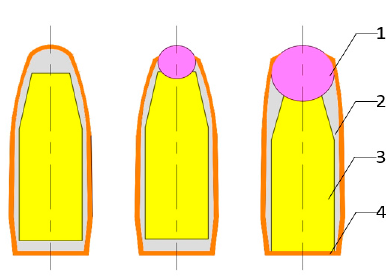
Figure 3. Three projectiles with different structures. 1 ZrO 2 ceramic ball, 2 Lead case, 3 Tungsten core, 4 copper jacket.